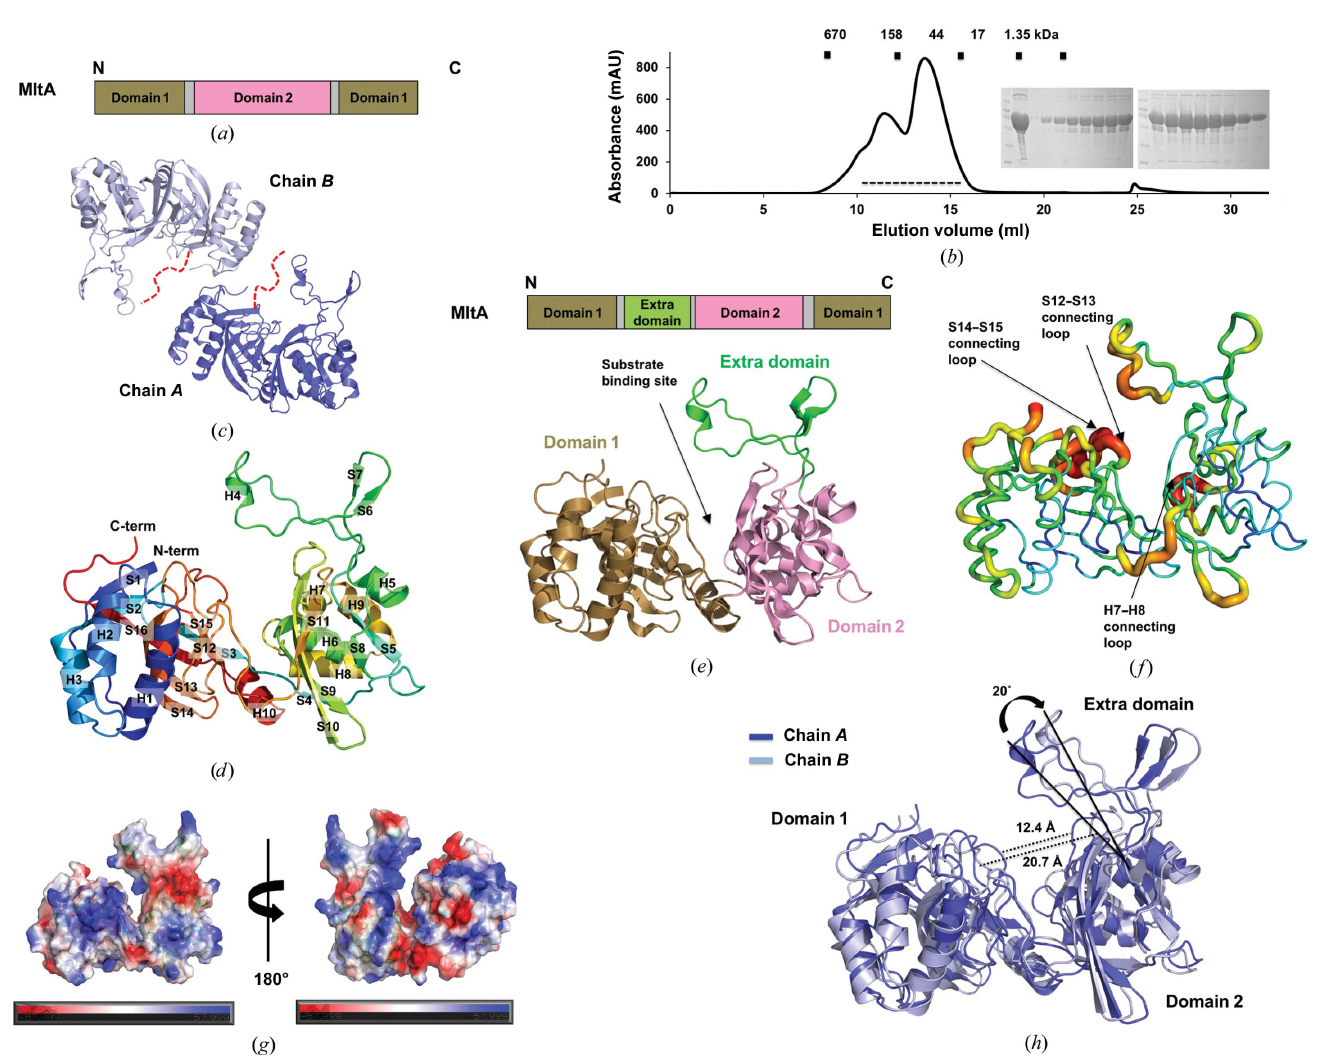
Figure 1 Crystal structure of abMltA. ( a ) General domain composition of MltA. ( b ) Size-exclusion chromatography profile. The results of SDS–PAGE performed to assess the identity and purity of the target protein are shown to the right of the main peak. The loaded fractions are indicated by a black dashed line. ( c ) Cartoon representation of two abMltA molecules in an asymmetric unit. Missing residues at the N-terminus of abMltA are shown by a red dashed line. ( d ) Rainbow-colored cartoon representation of monomeric abMltA. The chain is colored blue to red from the N-terminus to the C-terminus. Helices and sheets are labeled H and S, respectively. ( e ) A cartoon representation of the structure of abMltA showing the domain boundary in the structure. The putative substrate-binding site is indicated by a black arrow. ( f ) Putty representation showing the B -factor distribution in the structure of abMltA. Rainbow colors from red to violet in the order of B -factor values were used for visualization. Regions with the highest B -factor values are indicated by a black arrow. ( g ) Electrostatic surface of abMltA. ( h ) Superposition of the structures of the molecules in one asymmetric